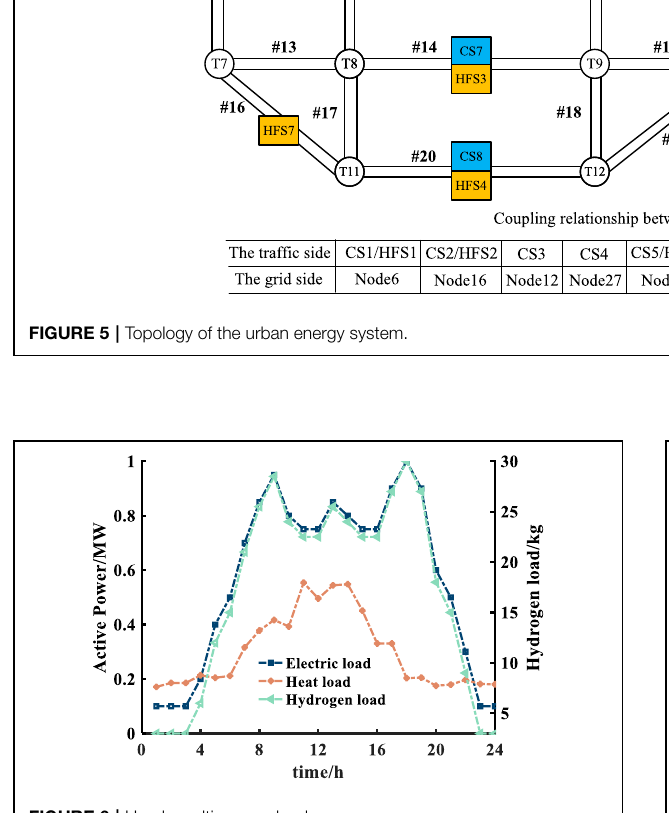
FIGURE 6 | Hourly multi-energy load.